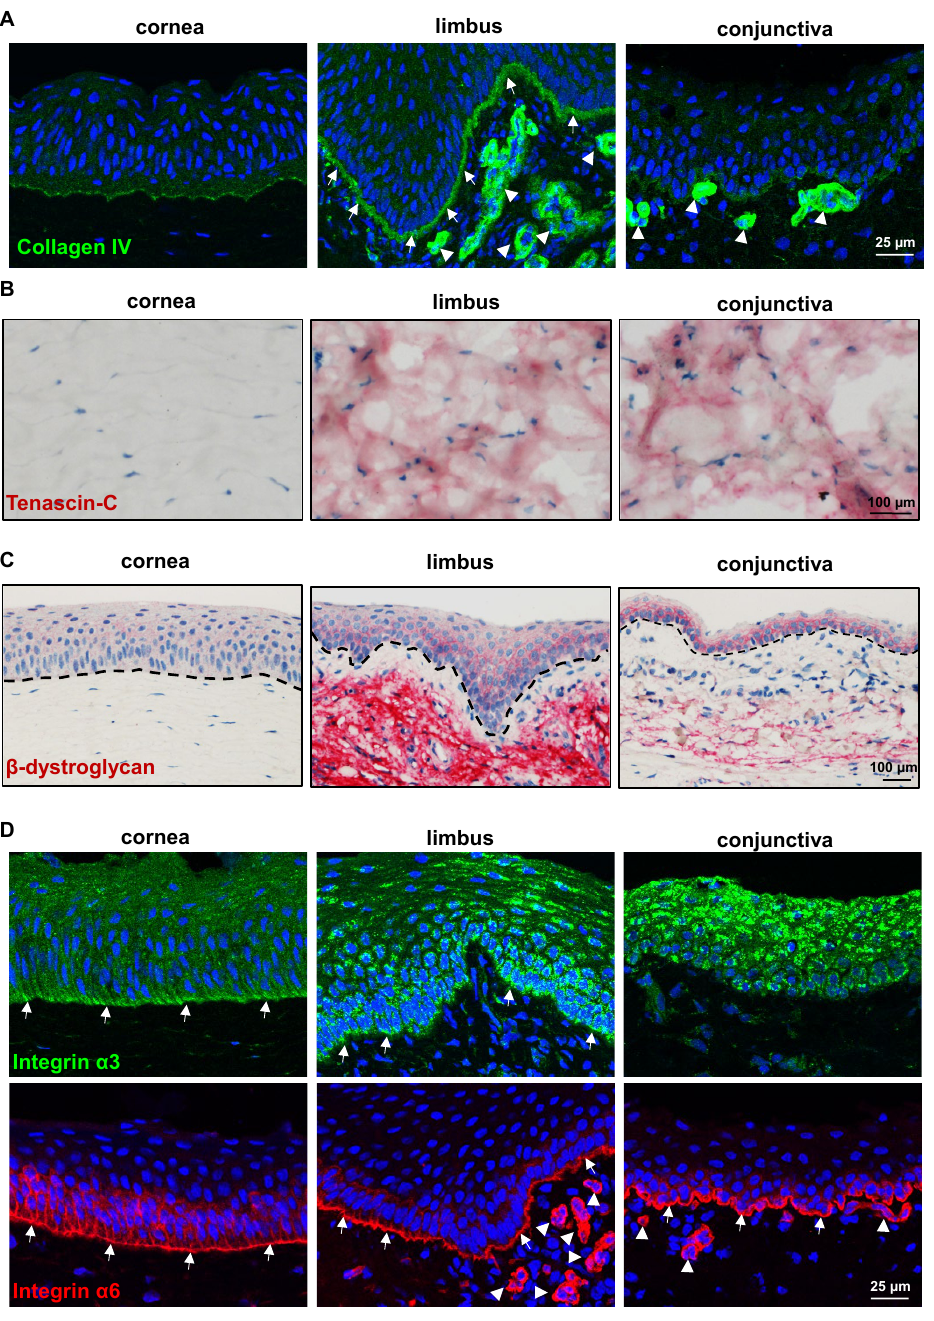
Figure 4. Expression analysis of extracellular matrix and adhesion molecules: ( A ) Immunohistochemistry and laser confocal imaging of corneoconjunctival tissue sections showing the collagen IV strongly stained limbal epithelial basement membrane (BM) (arrows); very weak staining in corneal and conjunctival epithelial BM; strong staining in the limbal and conjunctival vessel BM (arrowheads). Nuclei are counterstained with 4′,6 - diamidino -2- phenylindole (DAPI, blue). ( B ) Immunohistochemical analysis of corneoconjunctival tissue showing the tenascin(TN) -C expression in the stroma of limbus and conjunctiva (red) but not in the corneal stroma. ( C ) Immunohistochemical staining of corneoconjunctival tissue sections showing the β - dystroglycan expression in the basal cell membranes of the limbus and conjunctiva; faint membrane staining in the superficial cells of the limbus and conjunctiva as well as corneal epithelium; prominent staining in the limbal stroma but weak in the conjunctival stroma and absent in the corneal stroma. The